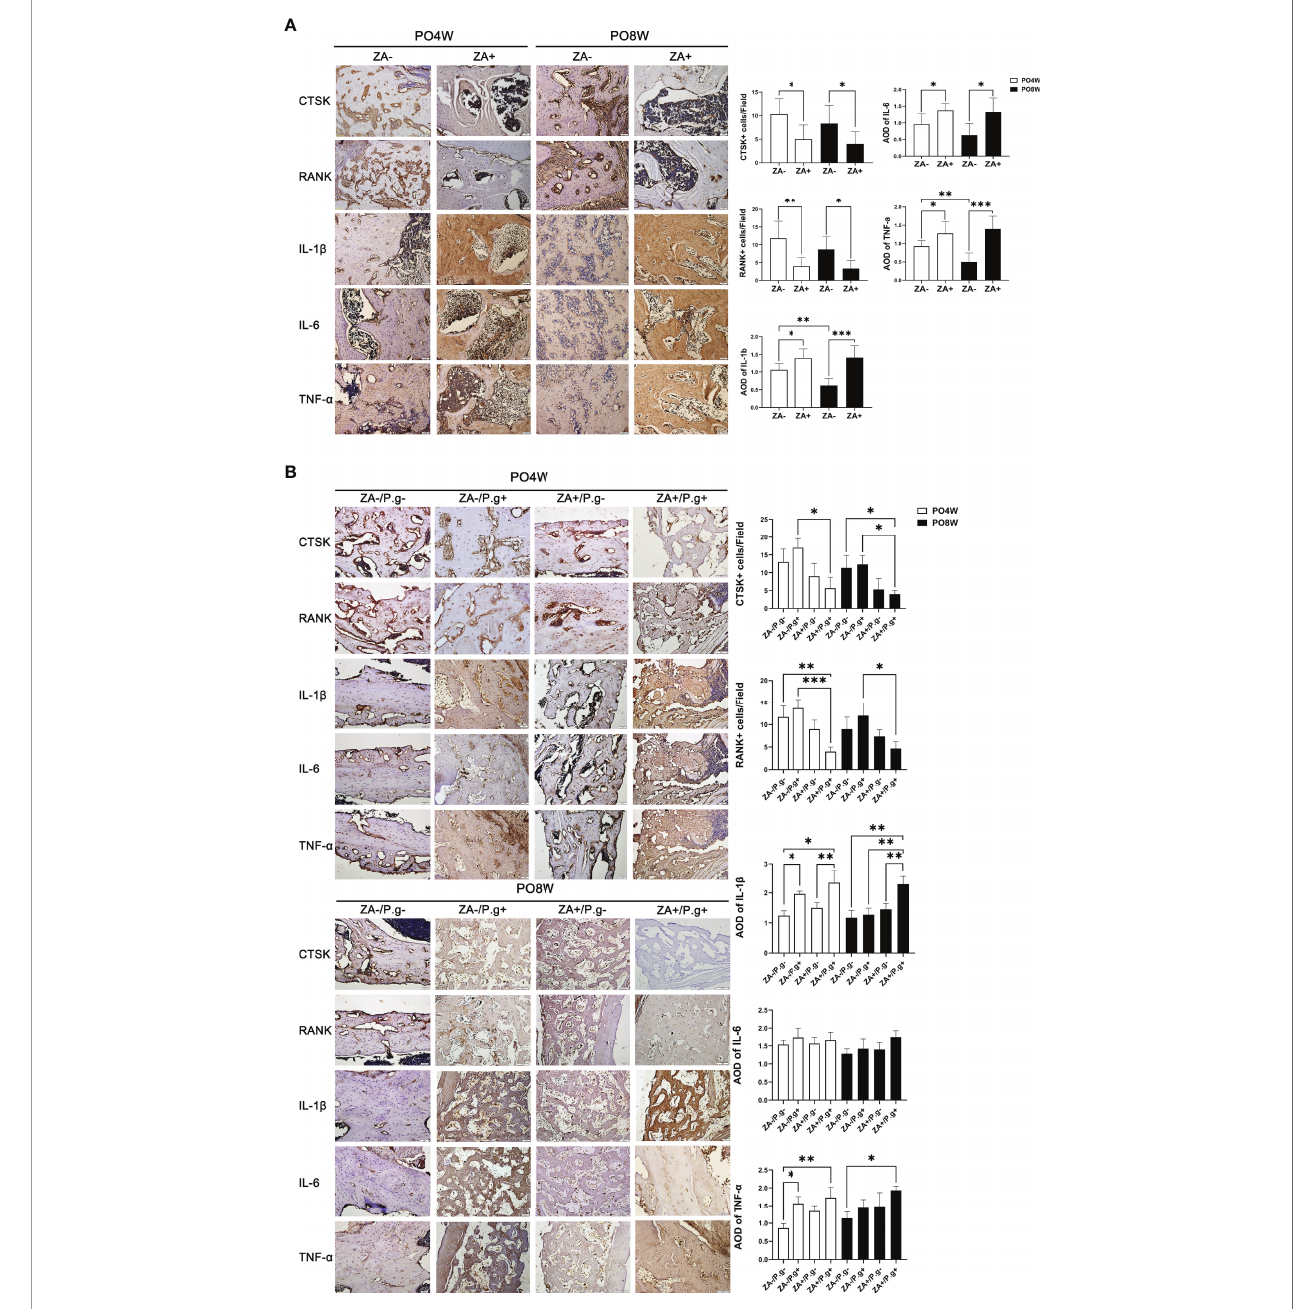
FIGURE 3 | ZA administration and local P. gingivalis injection signi fi cantly changed the expression level of osteoclastogenesis- and in fl ammation-related genes. (A) Representative sagittal immunohistochemical staining images and statistical quantitative analysis of mandible extraction sockets (bar: 50 m m, 20× magni fi cation). The number of CTSK- and RANK-positive cells in the ZA+ group (M) were signi fi cantly lower than in the ZA- group (M) at both 4 and 8 weeks postoperatively. The immunolabeling average optical density (AOD) for IL-1 b , IL-6 and TNF- a was higher in the ZA+ group (M); the degree of in fl ammation declined at 8 weeks compared to 4 weeks postoperatively in the ZA- group. (B) Representative sagittal immunohistochemical staining images and statistical quantitative analysis of femur defects (bar: 50 m m, 20× magni fi cation). Only in the ZA+/ P.g + group (F) a decreased number of CTSK- and RANK-positive cells was found. The immunolabeling average optical density (AOD) for IL-1 in the ZA-/ P.g + and ZA+/ P.g + groups (F) was higher than the other groups at 4 weeks postoperatively. The expression of TNF- a was also higher in the ZA-/ P.g + and ZA+/ P.g + groups (F) compared to the ZA-/ P.g - group (F). But at 8 weeks postoperatively, the expression of these cytokines declined in the ZA-/ P.g + group (F) while remained high in the ZA+/ P.g + group (F). There was no statistical difference in the expression of IL-6 between groups. PO4W, postoperative 4 weeks; PO8W, postoperative 8 weeks. *p <0.05, **p <0.01, ***p